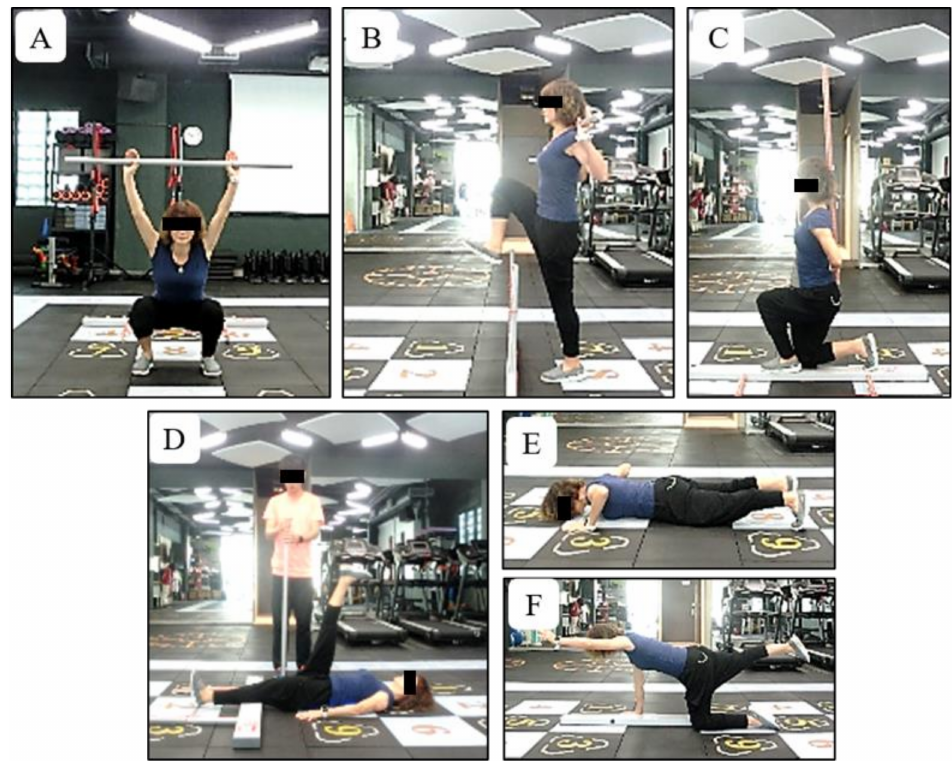
Figure 2. The functional movement screen exercises appraised in this study. ( A ) Deep squat; ( B ) hurdle step; ( C ) in-line lunge; ( D ) active straight leg raise; ( E ) trunk stability push-up; and ( F ) rotary